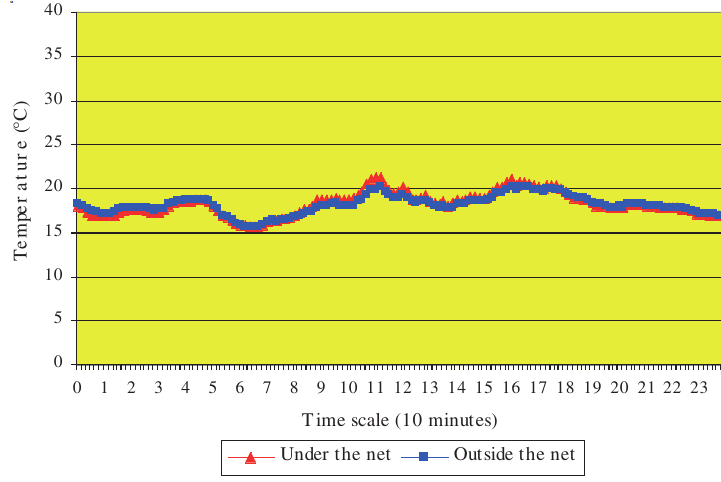
Figure 3. The mean daily course of temperature under the hail protection net and outside of it on especially calm days with little variation of temperature (T September 30/